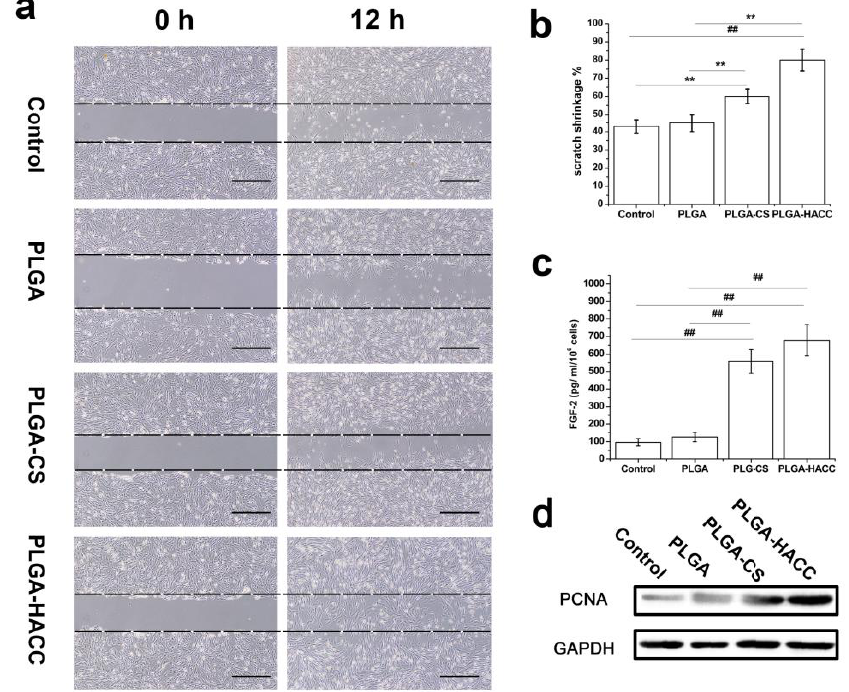
Figure 5. Migration of HDFs cultured with different fibrous membrane extract solution ( a ); statistical analysis of HDFs migrations ( b ); FGF-2 production in HDFs 24 h after treatment as determined by ELISA ( n = 5) ( c ); Western blotting of PCNA expression in dermal fibroblast proliferation ( d ); ## indicates p < 0.01, and ** indicates p < 0.05. The scale bar is 100 μm.